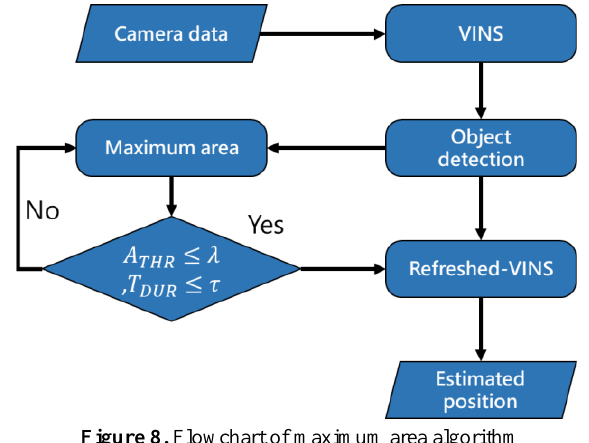
Figure 8. Flowchart of maximum area algorithm